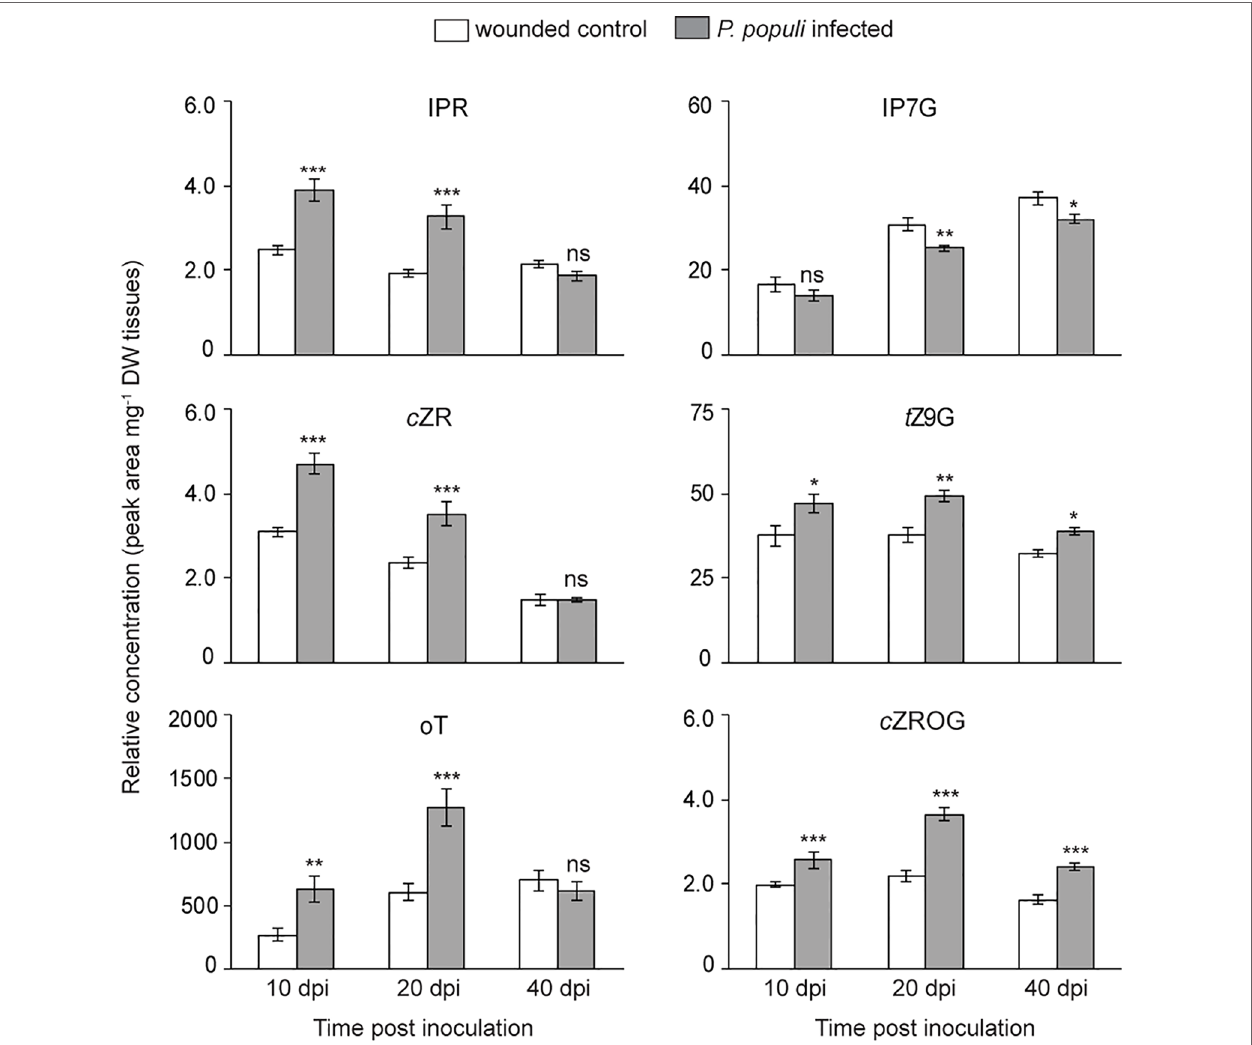
FIgURe 6 | Cytokinins (CKs) accumulate in P. populi- infected poplar stems. Samples were collected from separate trees at each time point. Relative levels of CKs were quantified by LC-tandem mass spectrometry. Data were analyzed by Student’s t-test (*, p ≤ 0.05; **, p < 0.01; and ***, p < 0.001; ns, non-significant). Data presented in figures are mean ± SE (n = 5). IPR, isopentenyladenine riboside; cZR, cis -zeatin riboside; oT, ortho -topolin; IP7G, isopentenyladenine-N 7 -glucoside; tZ9G, trans -zeatin N 9 -glucoside; cZROG, cis -zeatin riboside-O-glucoside; dpi, days post inoculation; DW dry